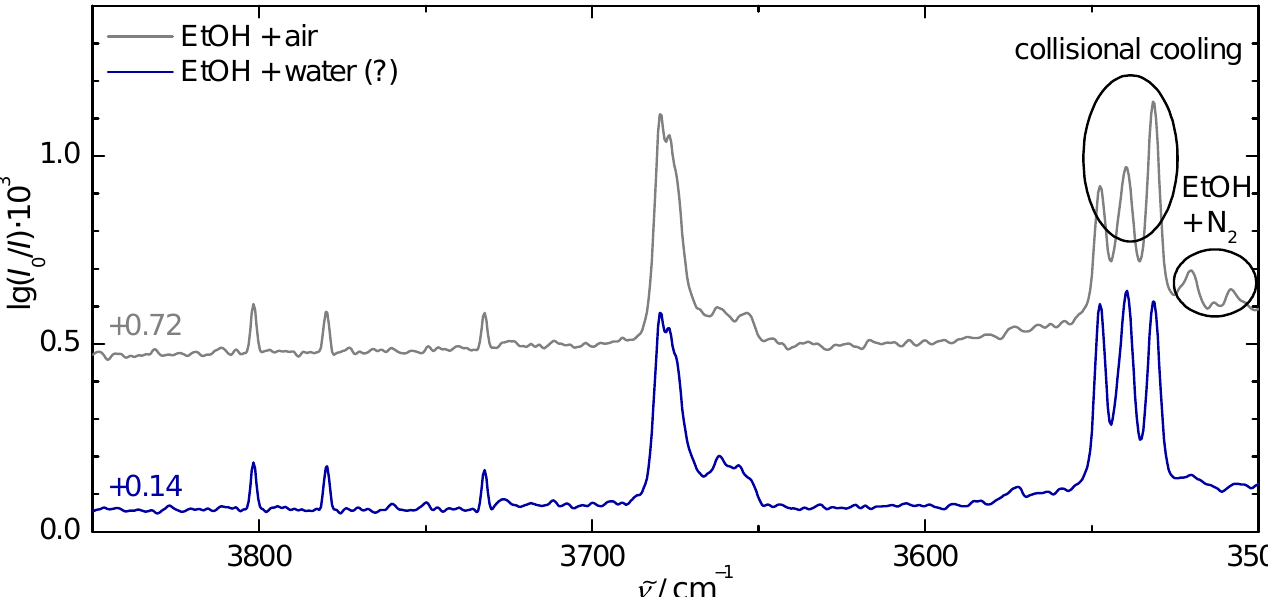
Figure 7. Ethanol gratin jet spectra with admixture of air (grey) or the rising water-containing impurity (blue). The spectra are displaced along the ordinate, as indicated above their respective